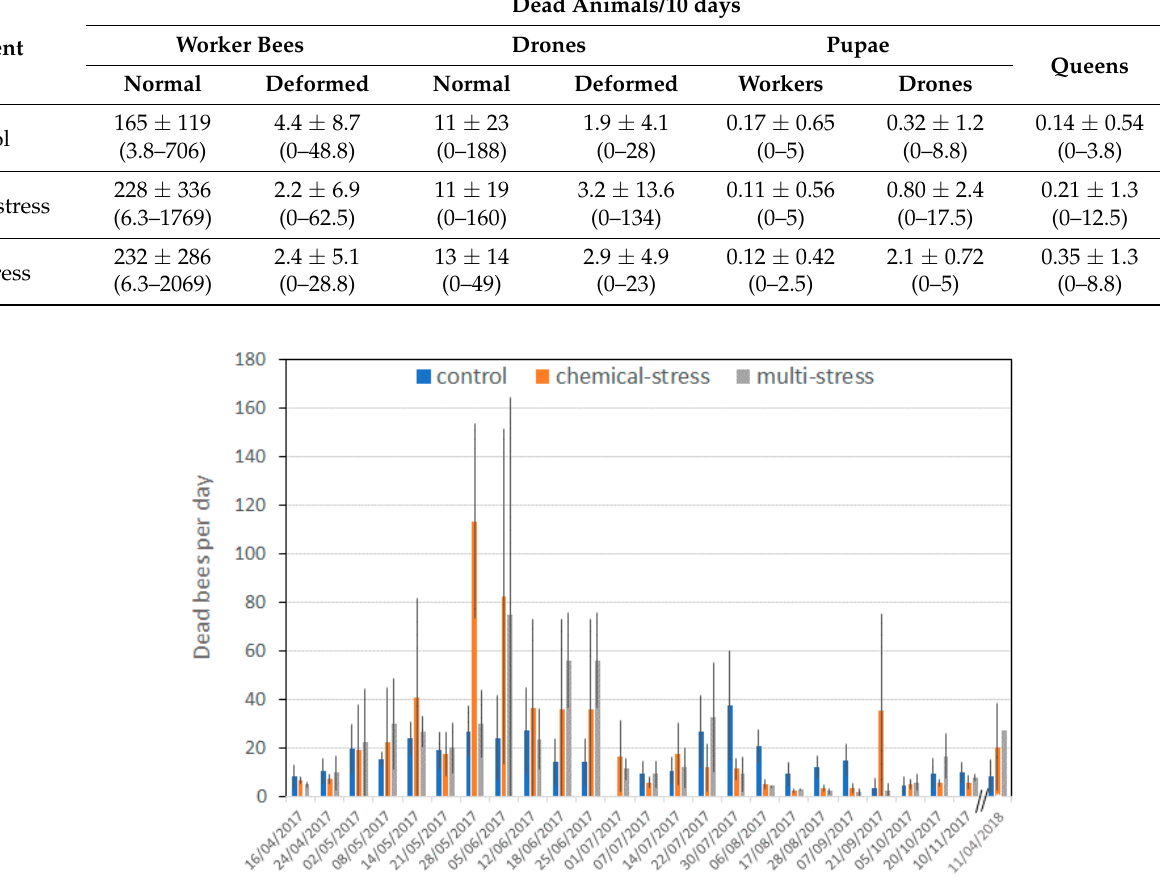
Figure 6. Mean number of dead worker bees per day in the control, chemical- and multi-stress sites as a function to the date of sampling.